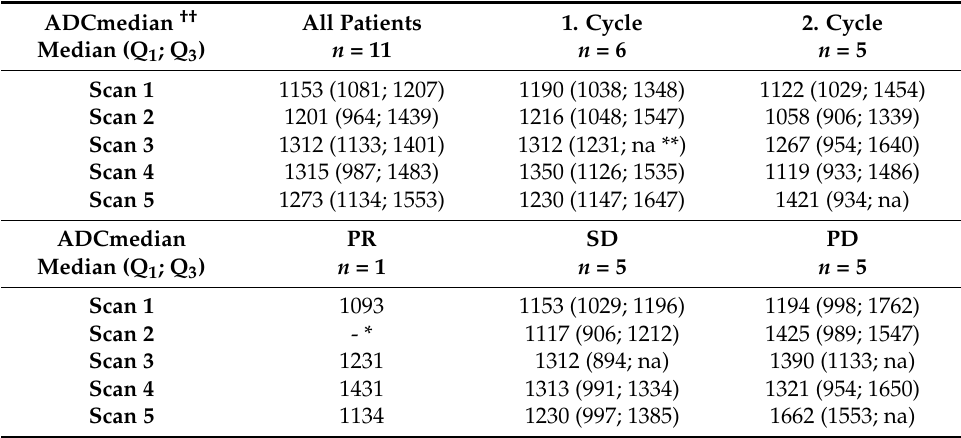
Table 5. Diffusion in tumor during